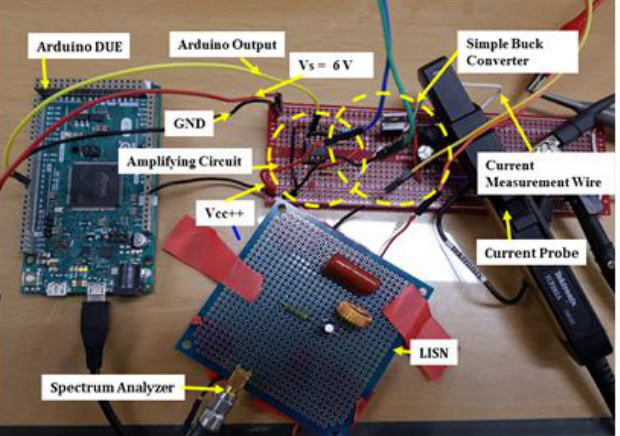
Figure 9. Experimental setup for the conducted emission analysis of a simple buck